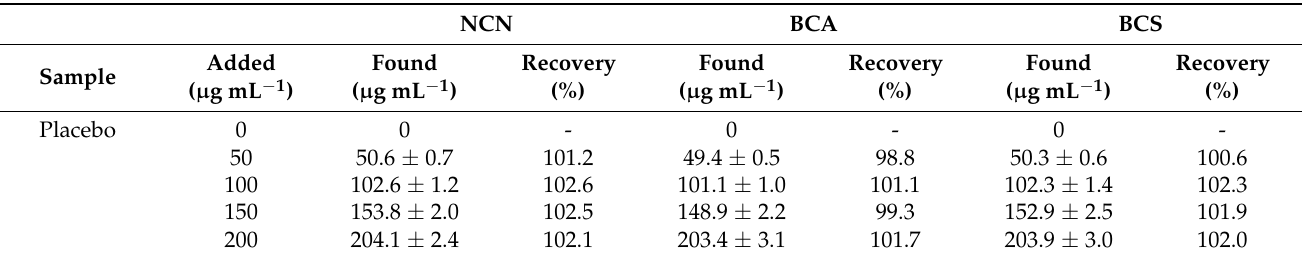
Table 4. Testing the accuracy of the new method for the determination of